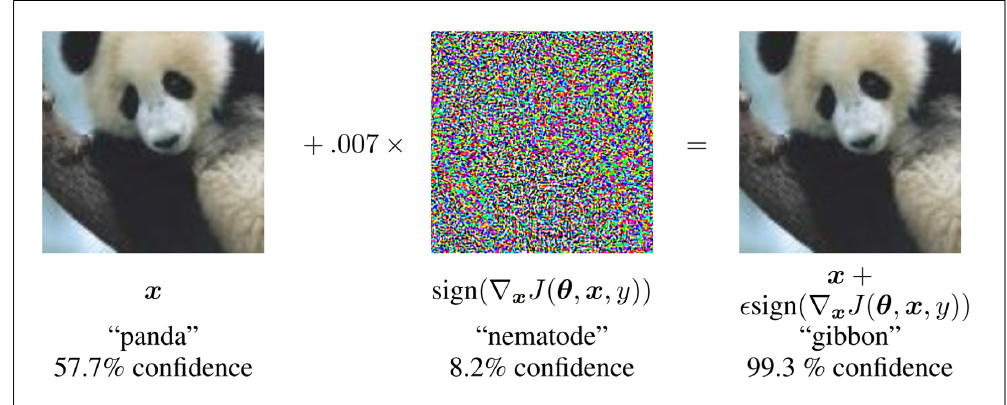
Figure 1. The model considers the original image as a “panda” (57.7%). Indeed, the image added a tiny perturbation is classified as a “gibbon” by the same model (99.3%), while the human eyes cannot identify the difference (Image Credit: Goodfellow et al.